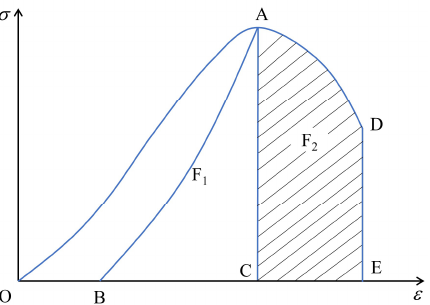
There is a certain relationship between the dissipated and strain energies during the uniaxial compression of coal, which is shown in Figure 17.